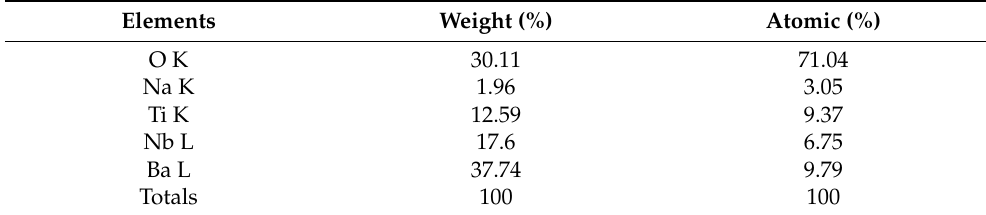
Table 3. The EDS spectrum analysis results of point A in Figure